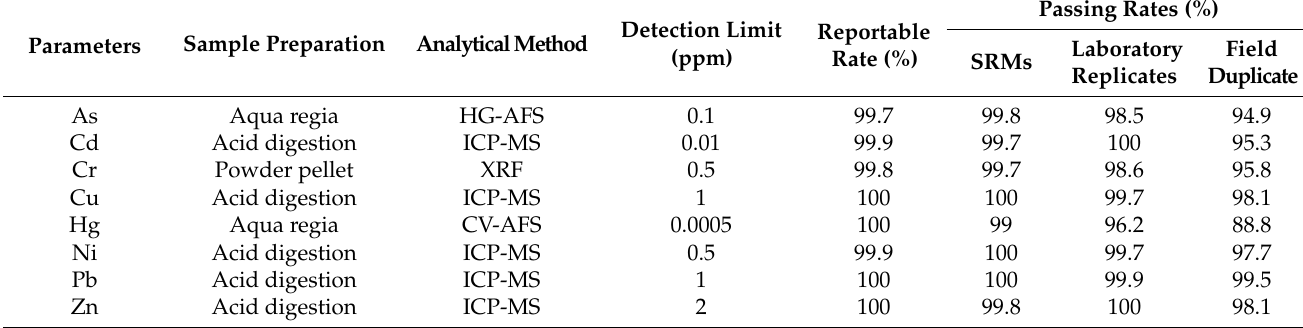
Table 1. Analytical methods and quality control.